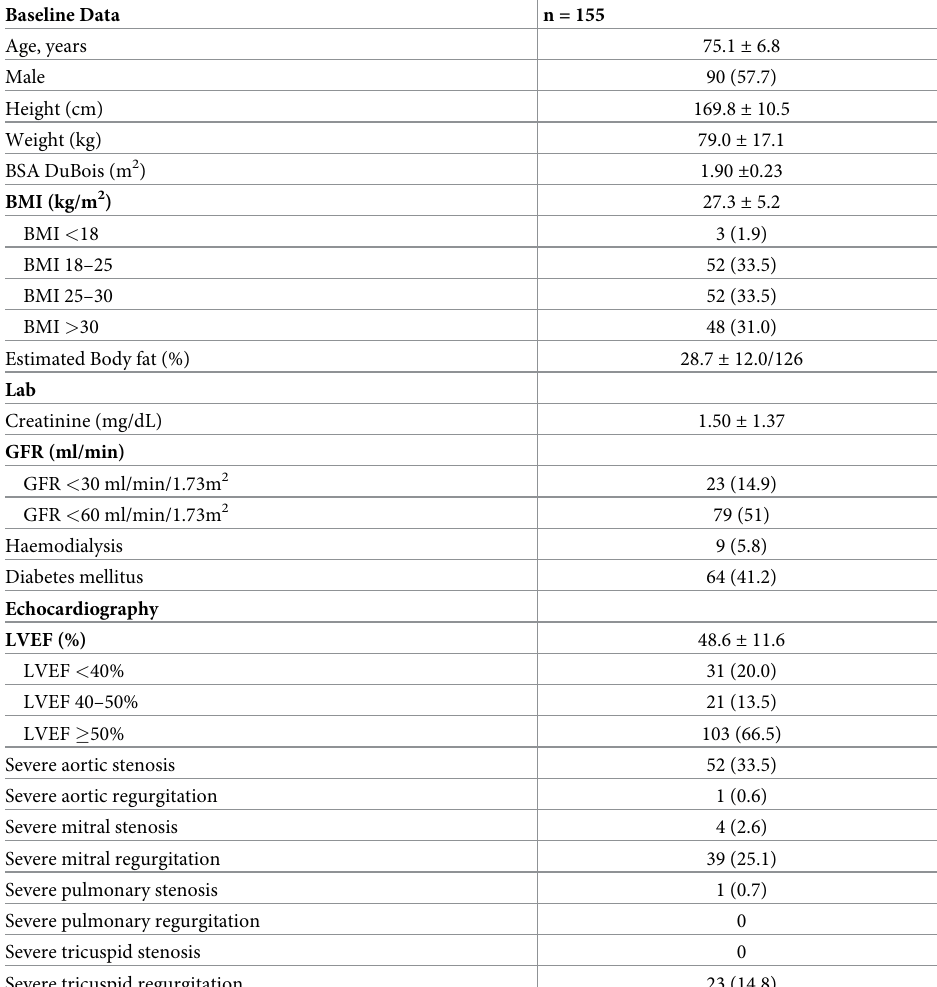
Table 1. Baseline